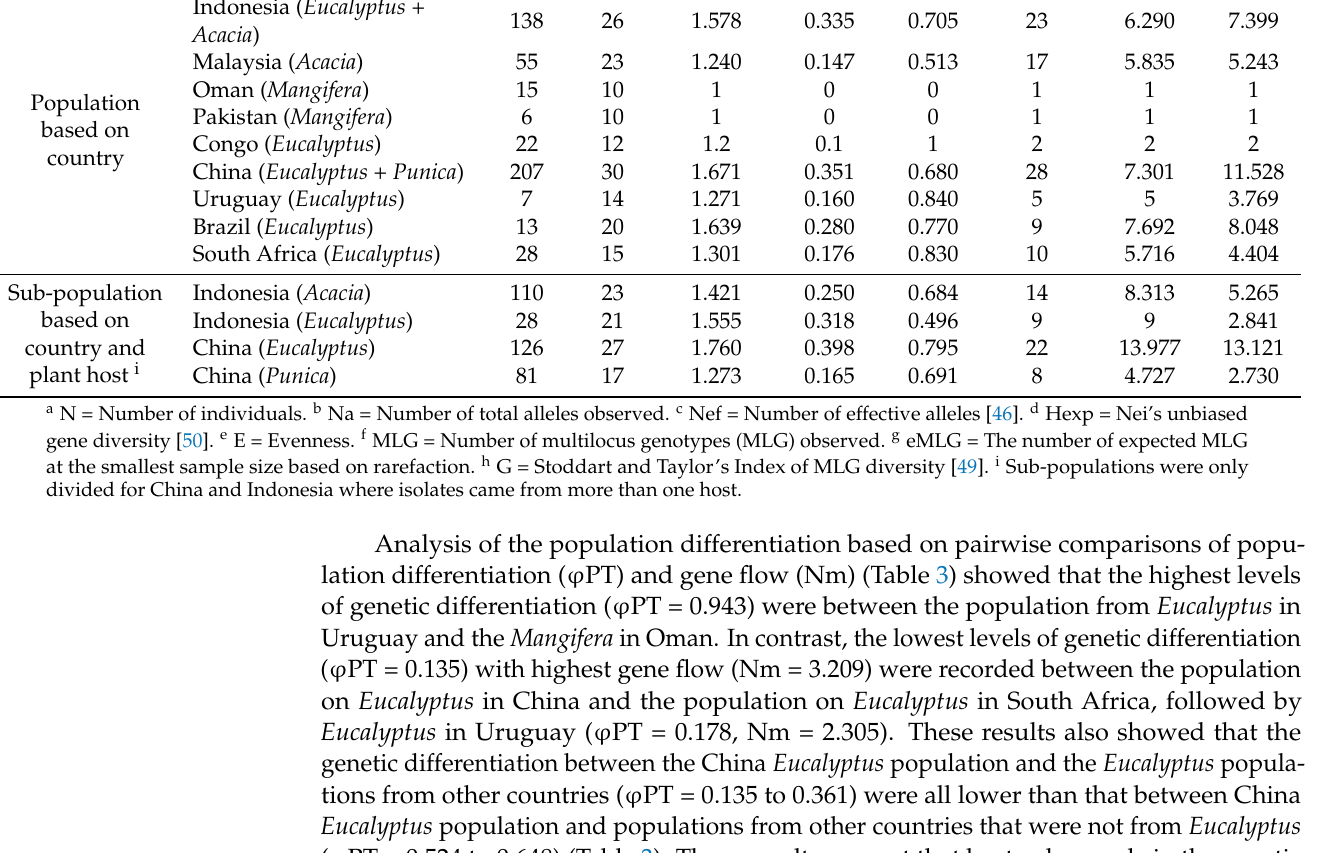
Table 1. Genetic diversity statistics for isolates of the Ceratocystis manginecans complex grouped into populations based on geographical location and host.